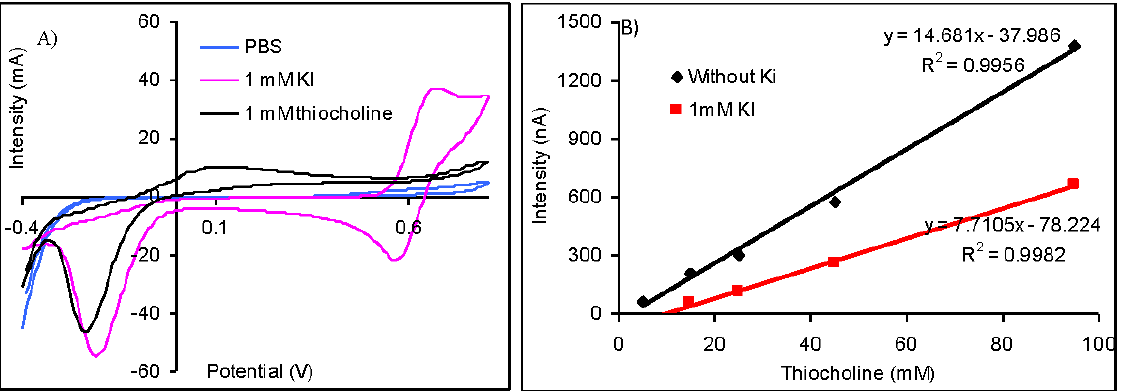
Figure 3. The results obtained using cobalt phthalocyanine screen-printed electrodes